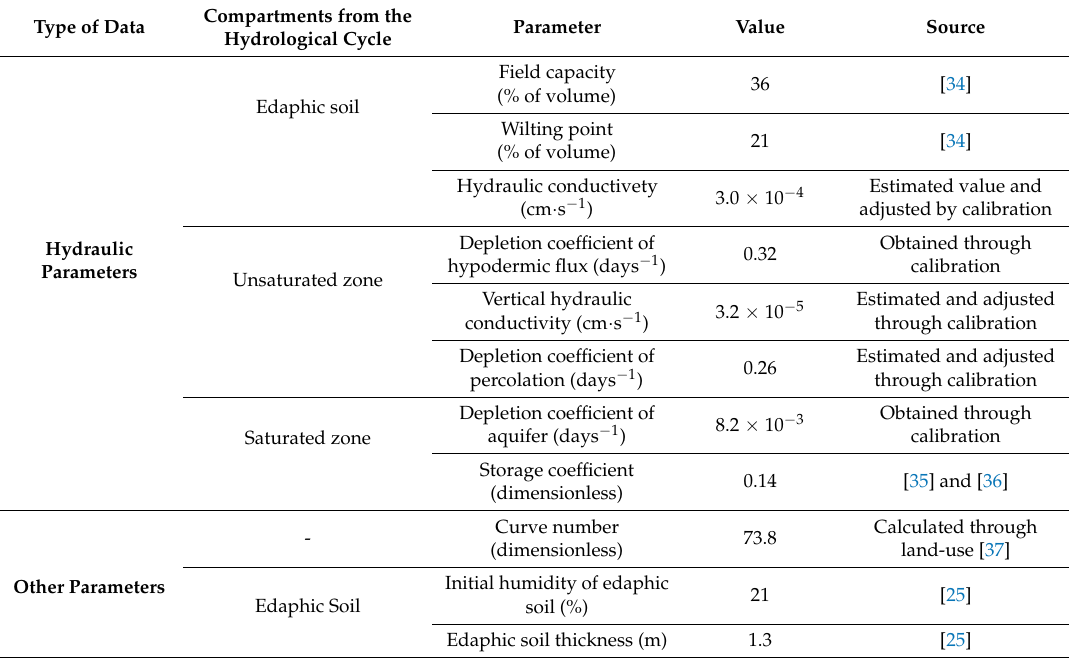
Table 1. Parameters used in the water balances model developed with Visual Balan